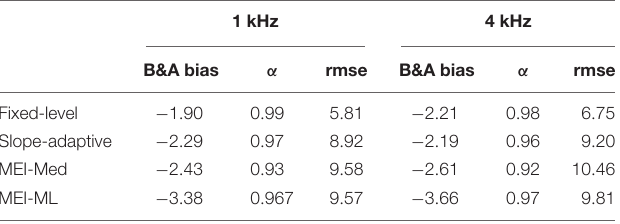
TABLE 5 | Reliability was assessed by comparing data for each of the four CLS procedures from visit one to visit two. 1 kHz 4